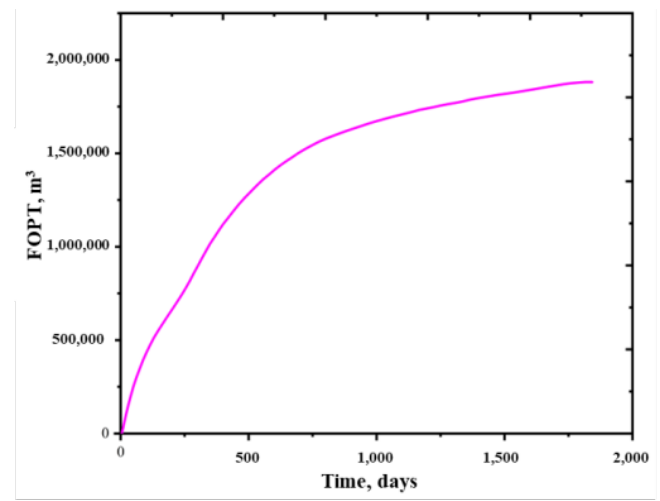
Figure 19. Field oil production rate for vertical well.